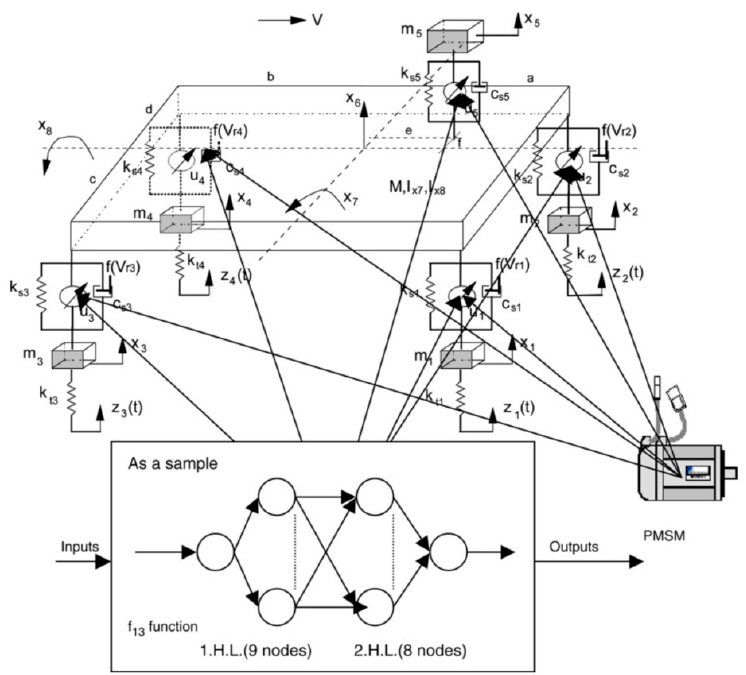
Figure 26. An integral controller based on artificial neural networks (ANNs) for active chassis suspension and active seat suspension system controls [73].